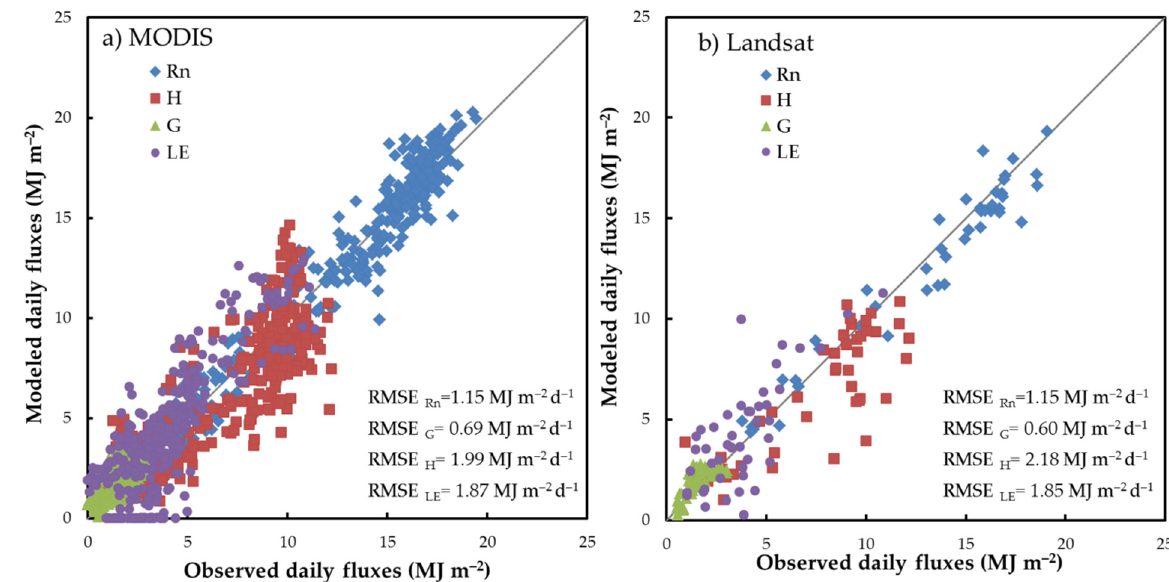
Figure 4. Comparison between observed and modeled daytime integrated energy fluxes obtained from DisALEXI procedure using ( a ) MODIS and ( b ) Landsat images for the years 2013–2015.